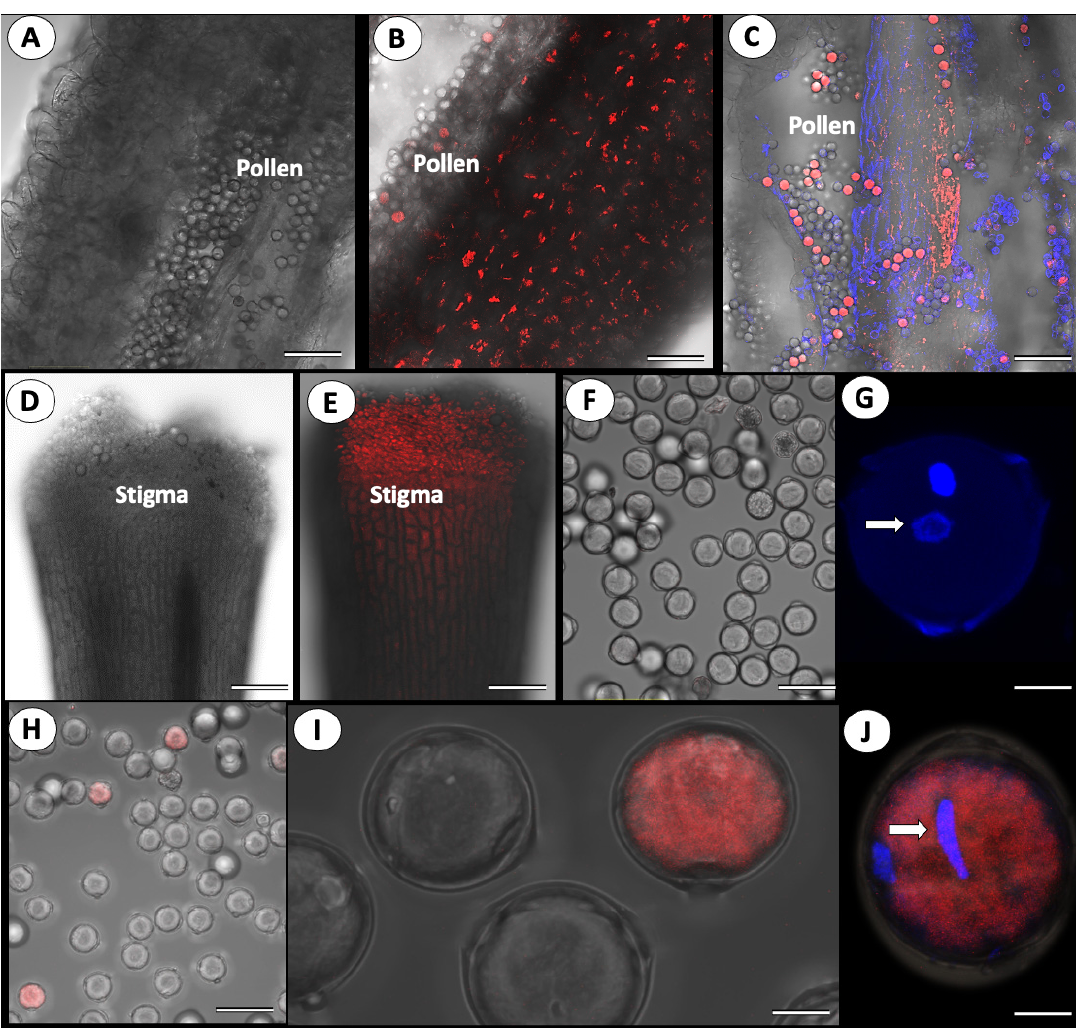
Figure 3. Representative confocal microphotographs of ToBRFV presence in the flower organs of tomato. In situ hybridization with a specific ToBRFV DNA probe fluorescently labeled with Cy3. Intact uninfected plants served as control. ( A ) Transverse section of the anther of control plant. Clean pollen and anther tissues are visible, Bar = 100 µm; ( B ) Transverse section of the anther of the infected plant. Note fluorescent signal in the anther tissue, pollen is partly infected, Bar = 100 µm; ( C ) Transverse section and double staining with DAPI and Cy3 of the infected anther. Fluorescence signal (red dots) is visible in several pollen grains, Bar = 200 µm; ( D ) Transverse section of control style, Bar = 200 µm; ( E ) Transverse section of infected style. The stigma of the infected flower looks heavily infected. Bar = 200 µm; ( F ) Pollen grains of control plant, Bar = 200 µm; ( G ) Close-up of the pollen grain of the control plant, double stained with DAPI and Cy3. Note the absence of red fluo- rescence signal (viral infection). The pollen nucleus is stained blue (arrow). Bar = 10 µm; ( H ) Close-up of the pollen grains in the infected plants. Bar = 20 µm; ( I ) Pollen grains of infected plants, Bar = 50 µm; ( J ) Close-up of the pollen grain of the infected plant, double staining with DAPI and Cy3. Note red fluorescence signal (viral infection). The pollen nucleus is stained blue (arrow). Bar = 10 µm.